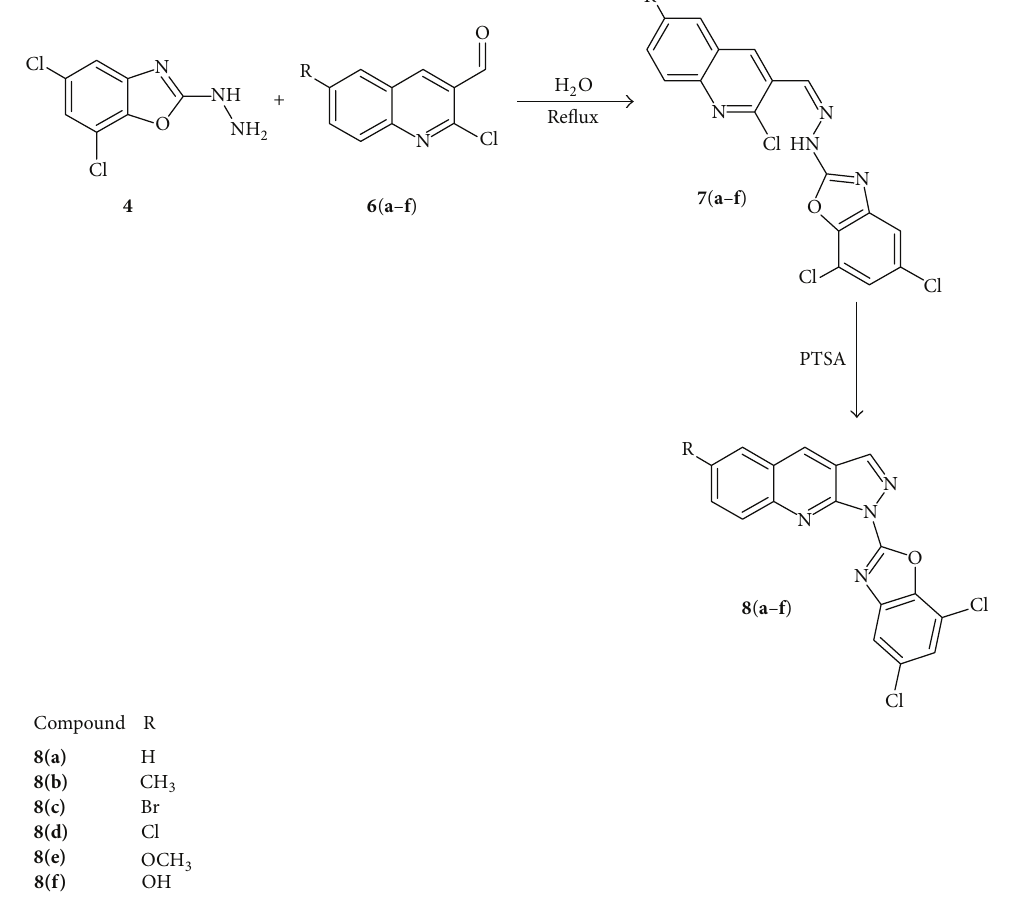
Scheme 4: Synthetic route for Compounds 8(a–f)